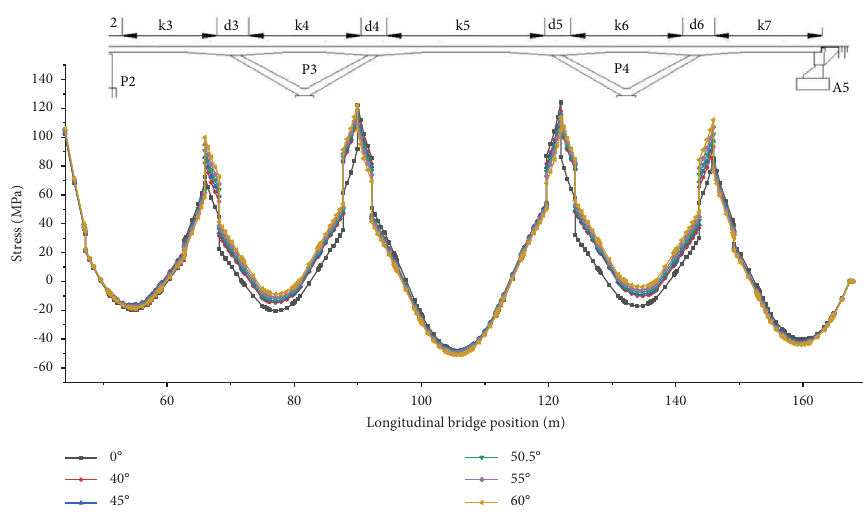
Figure 12: Comparison of stresses in the upper fange of a steel main